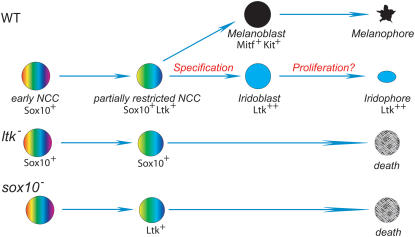
Model for iridophore development from neural crest.We propose that early NCCs are initially highly multipotent (indicated by the rainbow shading) and express Sox10, but not Ltk. During progressive fate restriction, a subset of partially-restricted, but still multipotent (fewer colours), cells are formed, marked by expression of Ltk; we propose that these cells' fates include multiple pigment cell-types (Other partially-restricted cell-types are expected to exist, but are not shown here for simplicity). Ltk signalling, acting together with Sox10 function, initiates iridoblast development (specification) in some cells (indicated by blue colour). In contrast cells adopting other fates, e.g. melanophores, extinguish Ltk expression, but may express other characteristic lineage-specific RTKs, e.g. Kit). Specified iridoblasts maintain Ltk expression as they differentiate into pigmented iridophores (blue). The early mutant phenotype precludes direct examination of the role of Ltk in these differentiating cells, although we favour cell proliferation as the likely late function. In ltk mutants (ltk
−), iridoblast fate specification fails. Cells survive for sometime (although Ltk expression is lost), before apoptosing; we cannot rule out the possibility that some precursors may transfate to other cell-types, although our data indicates most do not become melanoblasts or xanthoblasts, perhaps because of an intrinsic order of fate-specification in multipotent progenitors. In sox10 mutants (sox10
−) fate specification is also prevented; since in this mutant fate specification to all other fates is also prevented, these ltk-expressing precursors accumulate in a premigratory position, before they also eventually die.